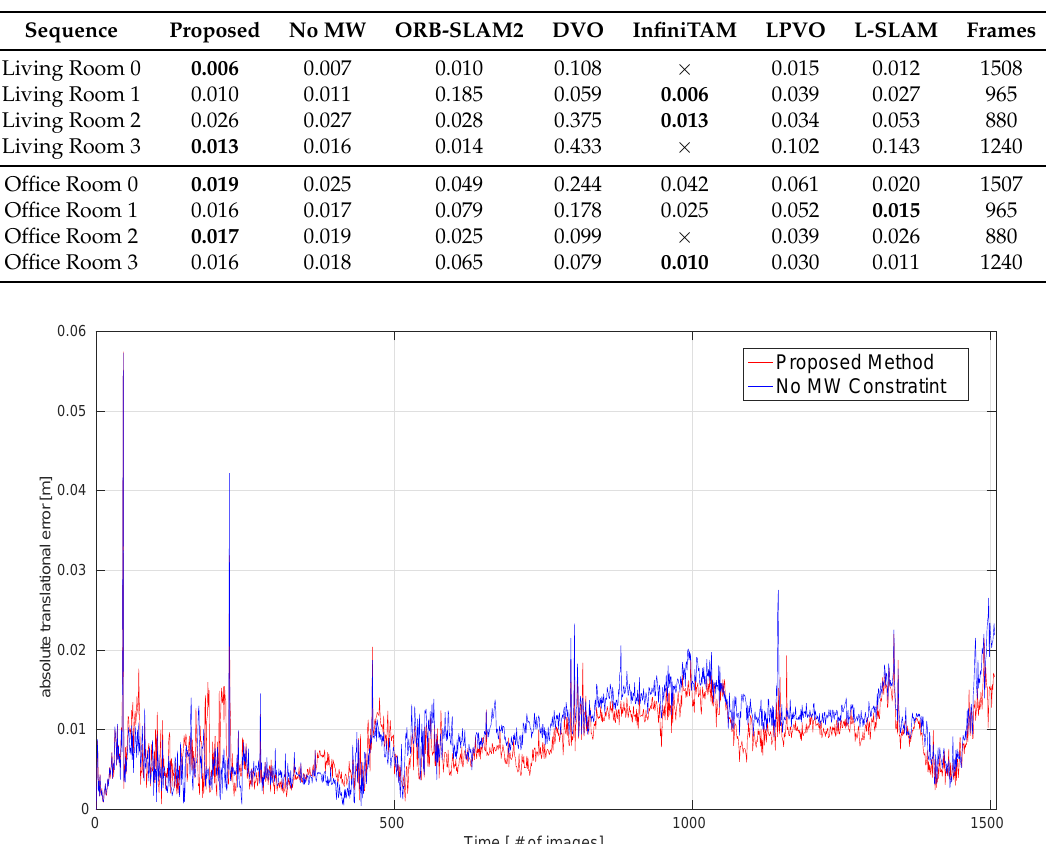
Figure 7. Performance evaluation for the MW constraint on the ’Living Room 0’ sequence. Absolute translational errors for our proposed method with and without the MW constraint are